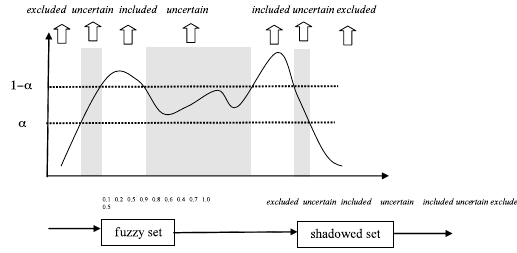
Figure 10. From fuzzy set A to its shadowed set representation and the resulting interpretation.